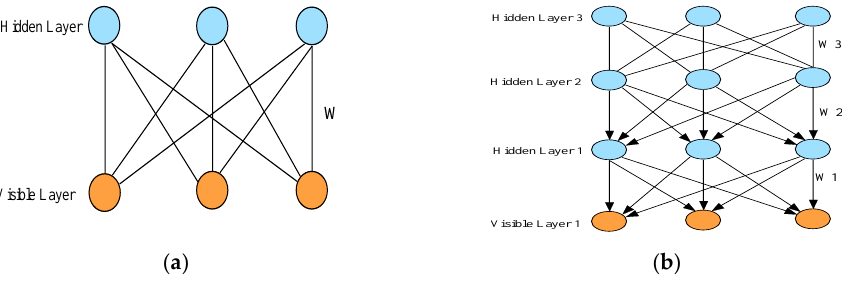
Figure 8. ( a ) Schematic of the Restricted Boltzmann Machine (RBM) architecture. ( b ) Schematic architecture of deep belief networks with one visible and three hidden layers